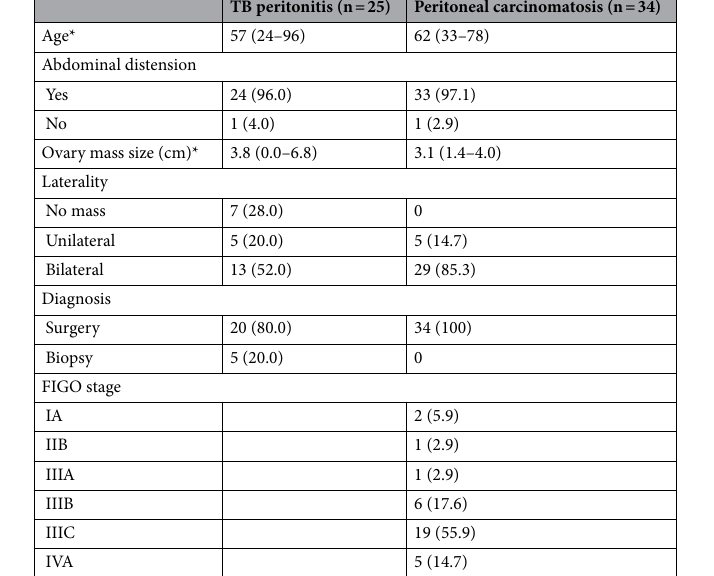
Table 1. Baseline demographics and clinical characteristics of the patients. Data are the number (percentage) of patients. *Data are presented as the median (range) of the